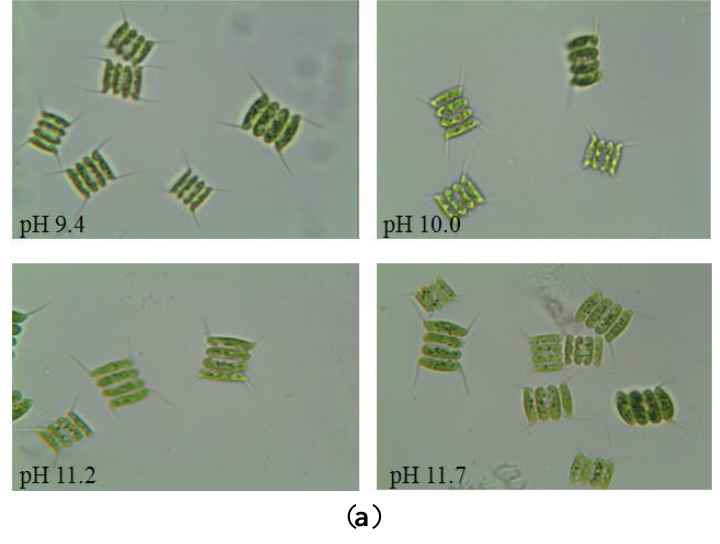
Figure 3. Morphotogical changes of algal cells with increasing pH observed with polarizing microscope at ×400 magnification after 6 h flocculation ( a ) Scenedesmus quadricauda #507; ( b ) Chaetoceros muelleri